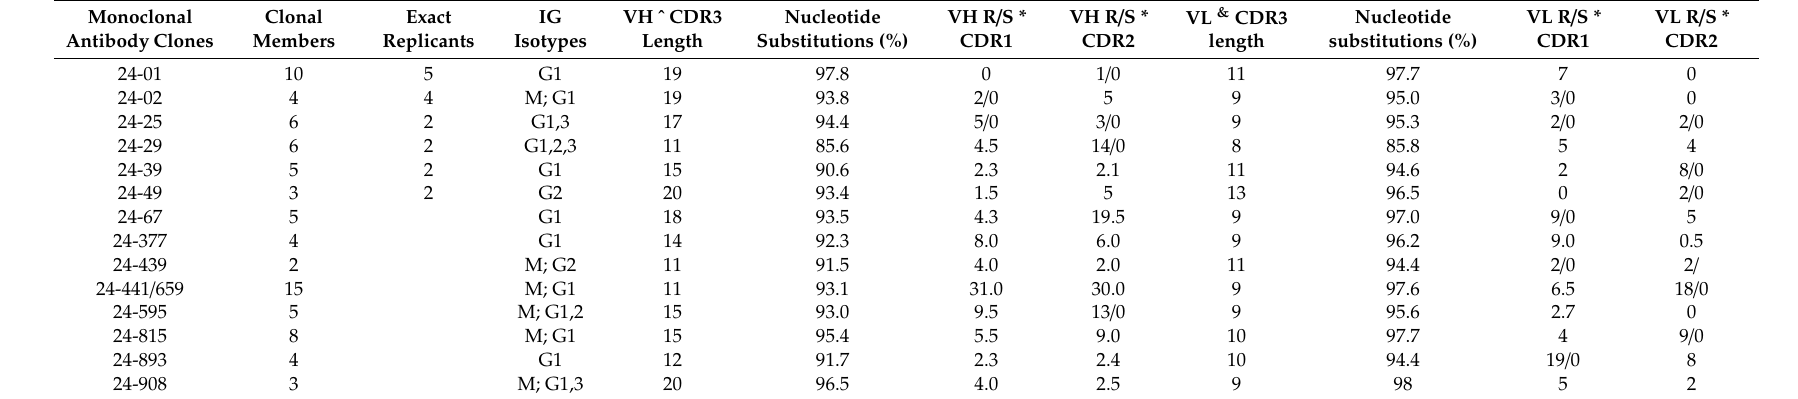
Table 2. Putative anti-Kawasaki disease etiology